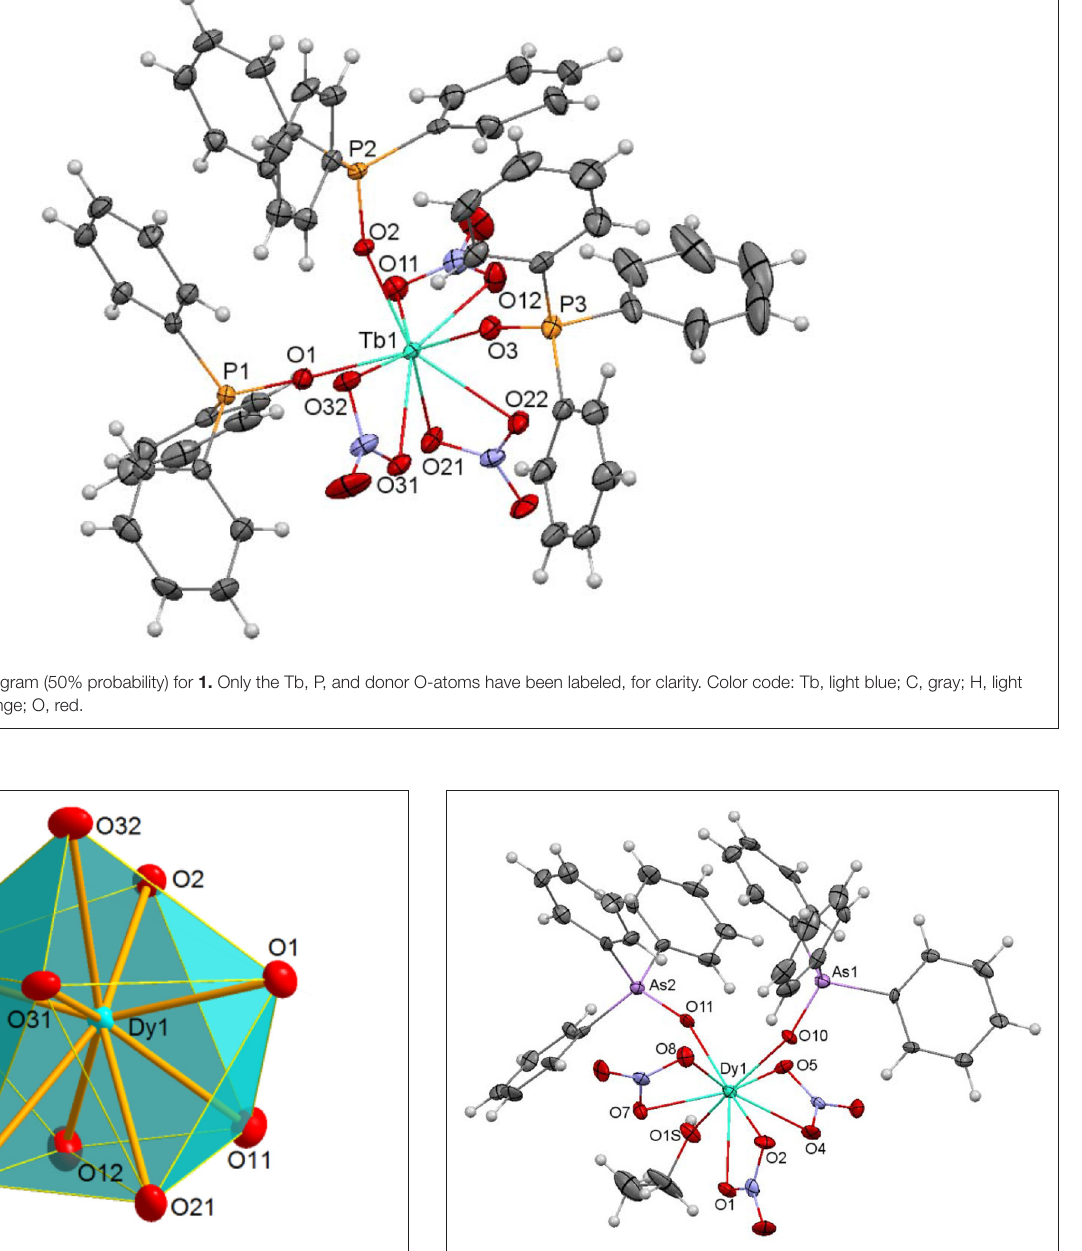
FIGURE 4 | Ellipsoids diagram (50% probability) for 4 . Only the Dy, As, and donor O-atoms have been labeled, for clarity. Color code: Dy, light blue; As, violet; C, gray; H, light gray; N, dark blue; O,